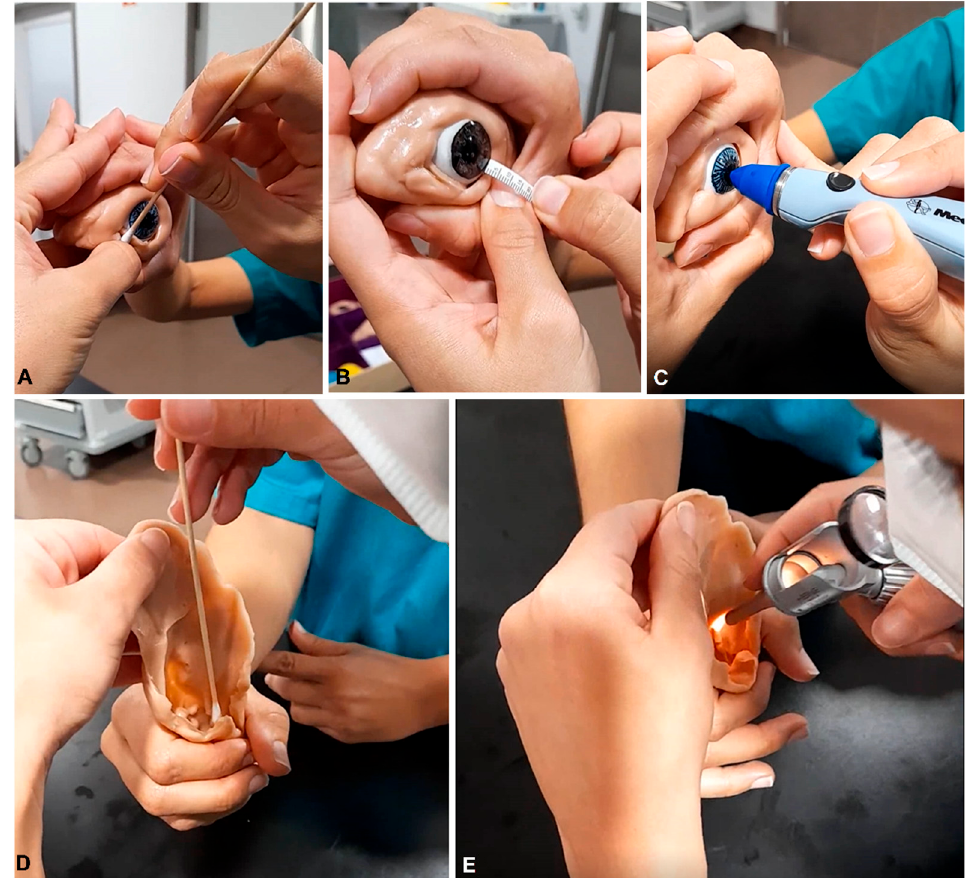
Figure 4. Students using the models to practice ophthalmology ( A – C ) and otoscopy procedures ( D , E ). By working in pairs, students obtained conjunctival swabs ( A ), performed the Shirmer’s test ( B ), and used the tonometer to assess the intraocular pressure ( C ). They also obtained ear canal swabs ( D ) and used the otoscope ( E ). In the ear canal, the tympanic membrane could be changed to represent simulated clinical conditions (inflammation and ruptured tympanum).